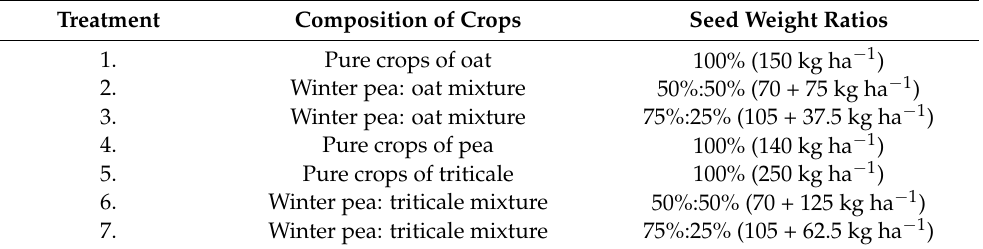
Table 3. Treatment details of the field experiments. Each treatment was harvested at two different maturity stages (1st stage: full-flowering stage of winter pea and beginning of milky stage of cereals; 2nd stage: emergence of firsts pods for pea and milky/waxy stage of cereals).